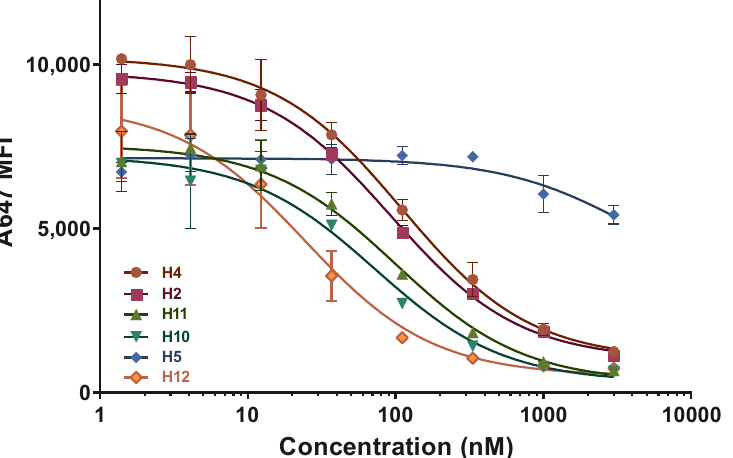
Figure 4. Affinity binding to ASGPR in primary mouse hepatocytes. Oligonucleotides derived from 17 mer antiviral sequence. Table 3. Binding affinity to ASGPR using a mouse primary hepatocytes fluorescence-based assay [12,14].